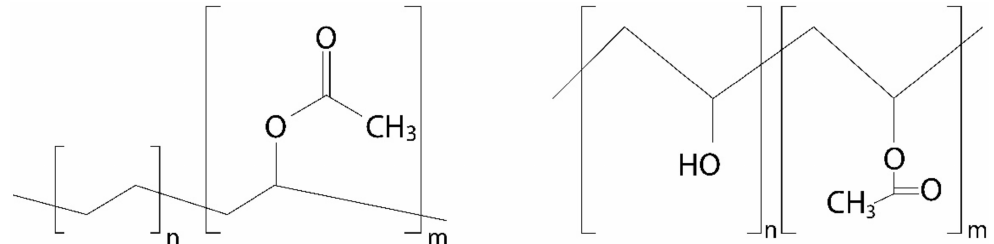
Figure 3. Chemical structures of EVA (left) and partially acetylated PVA (right). Table 1. Effect of VA content on the crystallinity of polyethylene-vinyl acetate [20]. Sample a VA (wt%) b DOC c PEVA11